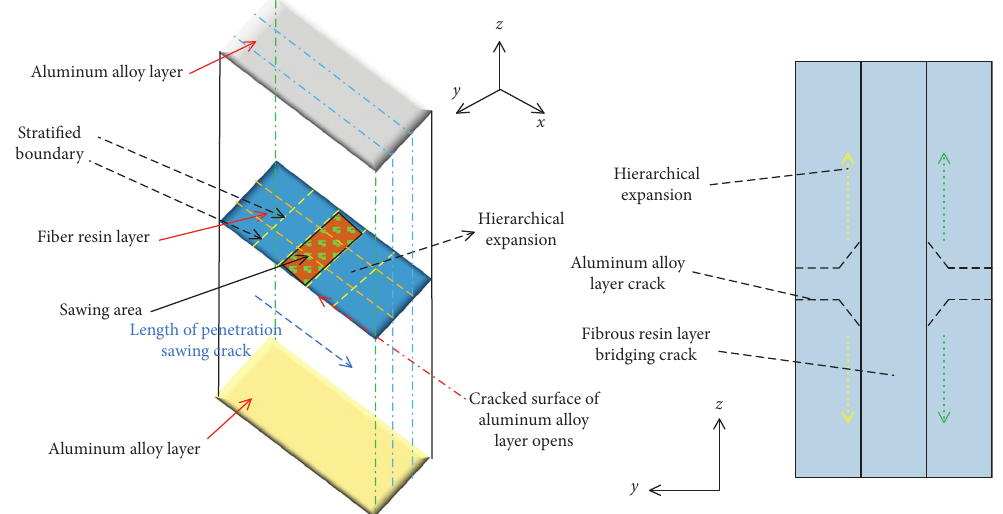
Figure 1: Fatigue crack growth mechanism of fiber-reinforced aluminum alloy